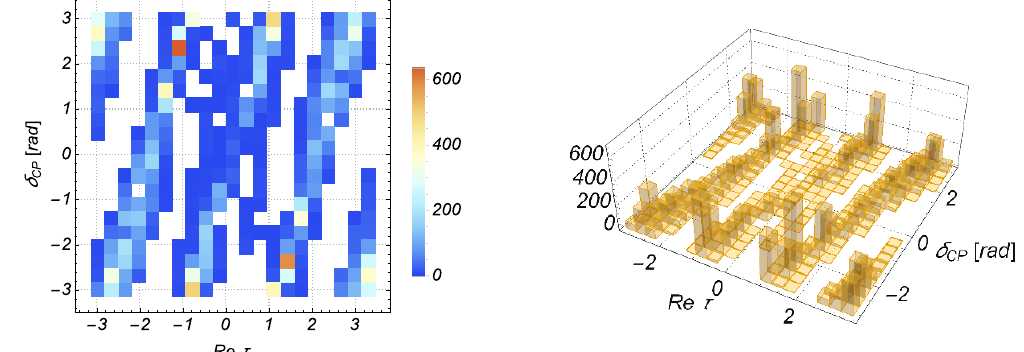
Figure 14 . Distributions of the CP-violating phase δ CP vs. real part of complex structure modulus Re τ for Im τ = 1 . 9 in Pattern IV.